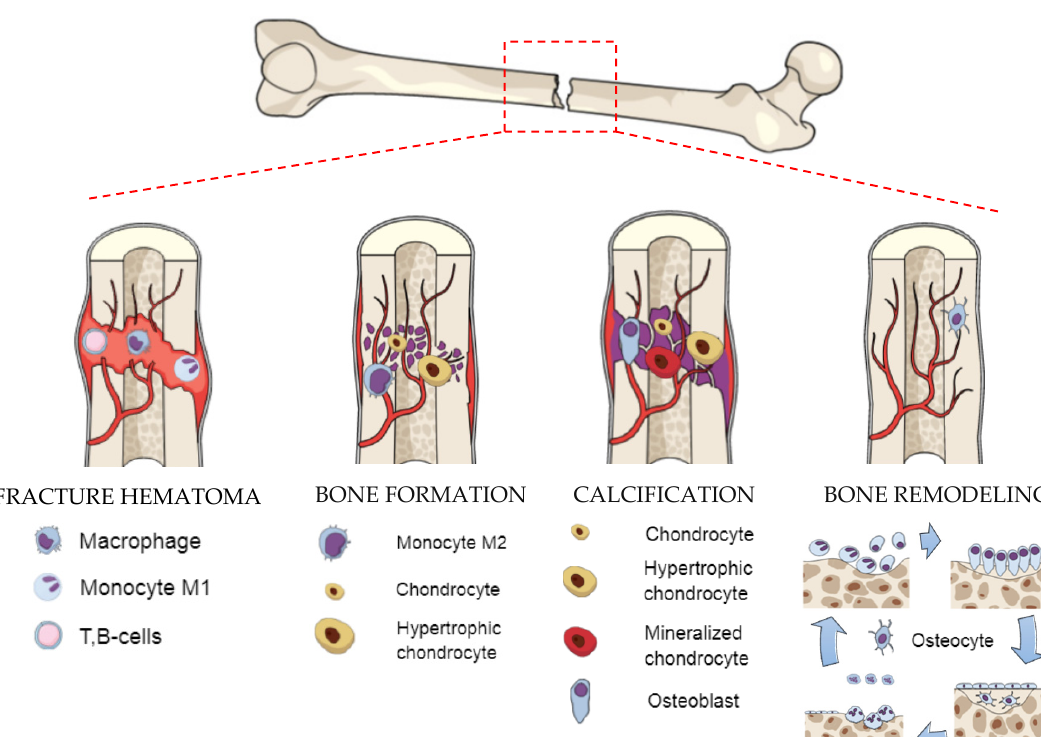
Figure 1. Scheme of natural bone formation